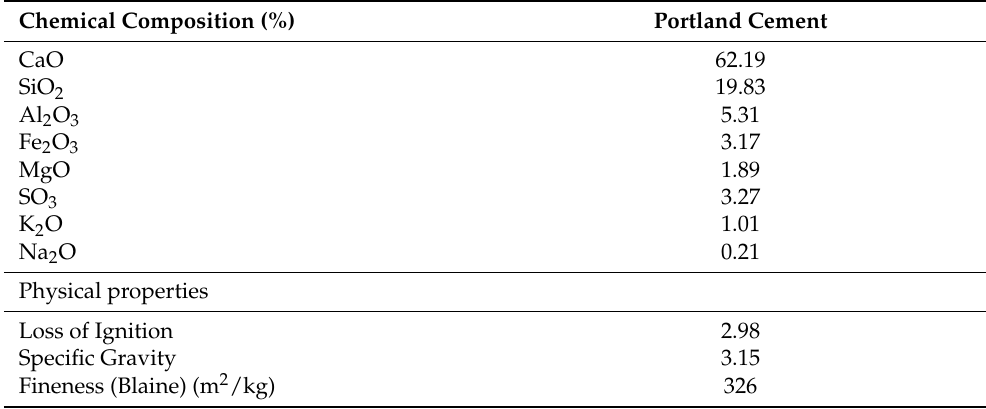
Table 1. Chemical composition and physical properties of Portland cement.